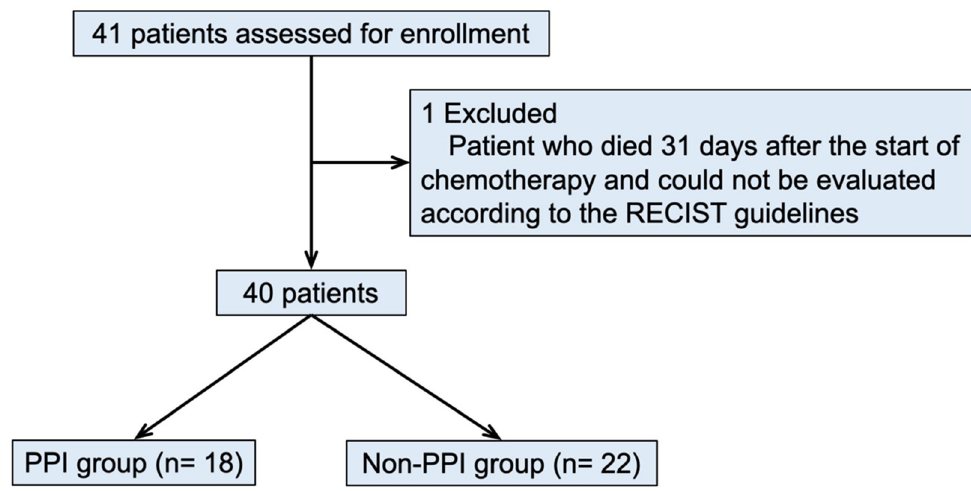
Figure 1. Flow chart of patient enrollment .